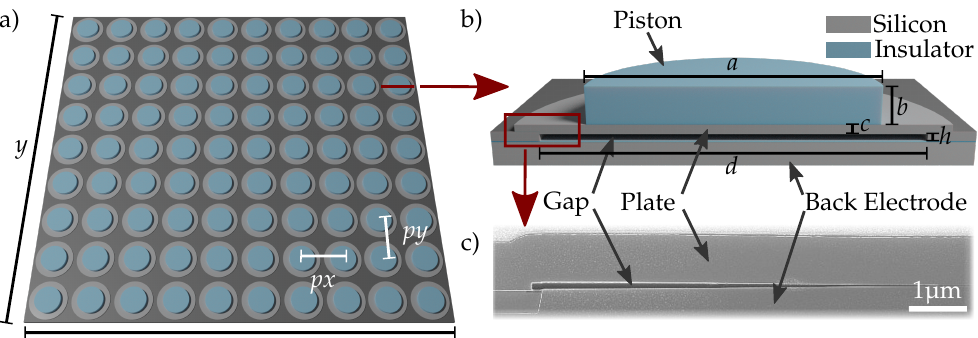
Figure 1. CMUT design with center plate stiffening (piston) on top of a conductive plate. The stiffen- ing is realized with insulating materials (blue), whereas plate and back electrode are made of silicon separated by a thin insulating layer. ( a ) An array of 10 × 9 cells on a roughly squared grid with pitches p x and p y forms the active area x-by-y of a single element. ( b ) Schematic representation of the cell cross section (not to scale). The denoted design parameters are given in Table 2. ( c ) SEM image of plate edge with anchor and gap. Left lower corner shows anchor isolation not depicted in ( b ). The plate is in contact with back electrode due to sample preparations for SEM